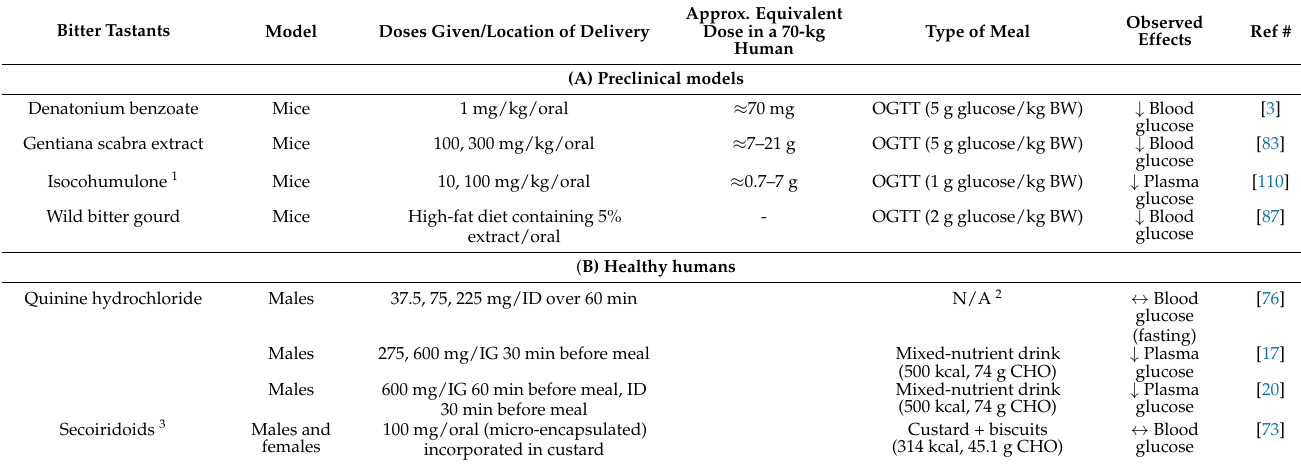
Approx. Equivalent Dose in a 70-kg Type of Meal Observed Effects Human